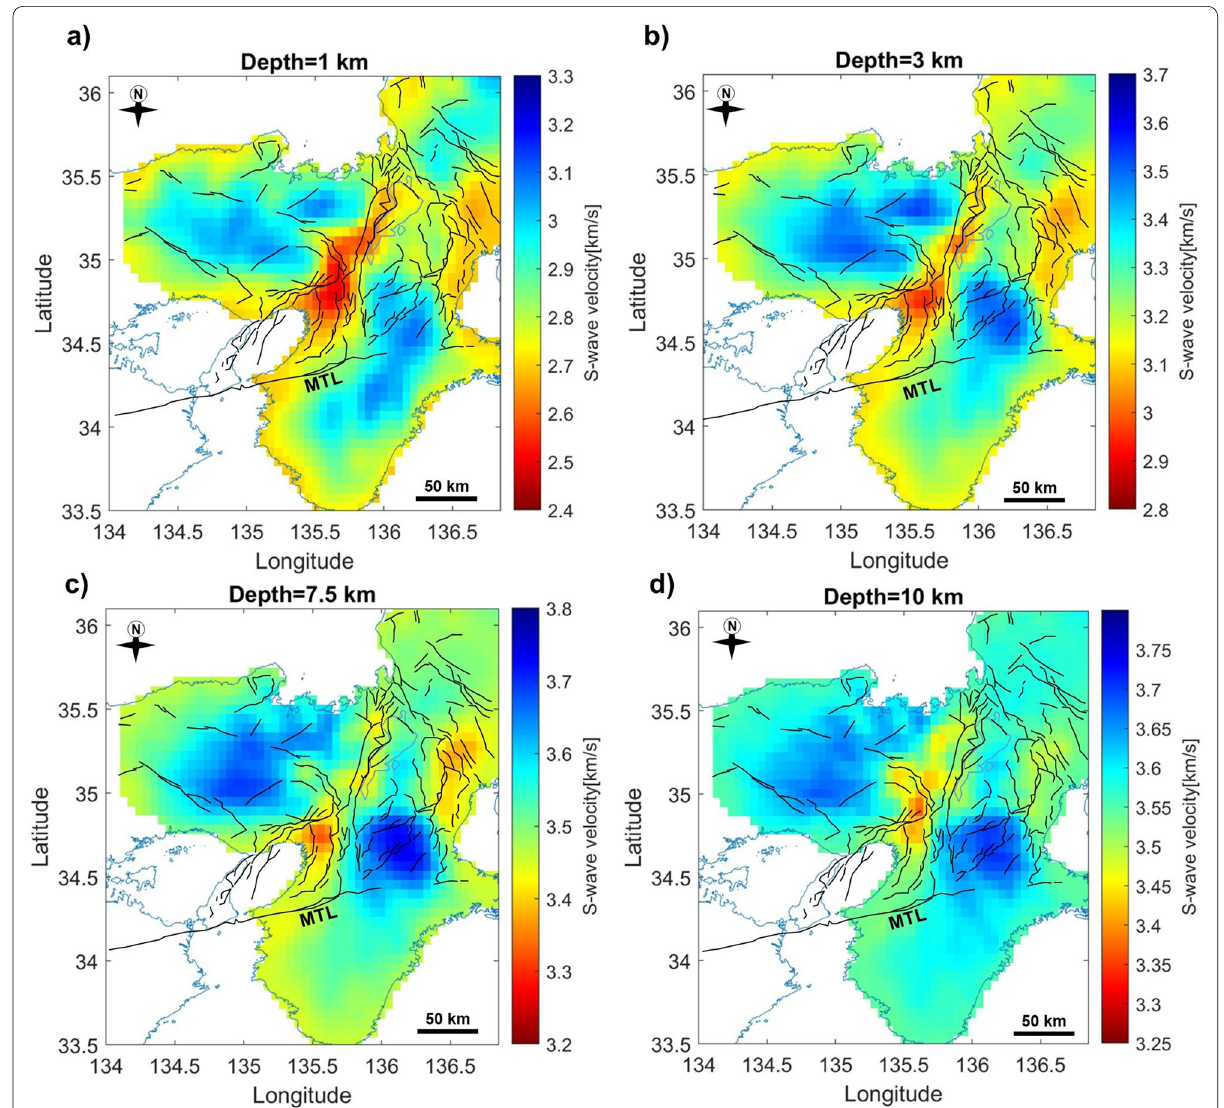
Fig. 8 . Horizontal slices of the S-wave velocity model at discrete depth levels below sea level. a–d S-wave velocity models overlaid with active faults (black lines). Depth is shown above each respective panel. Also shown is the location of the Median Tectonic Line